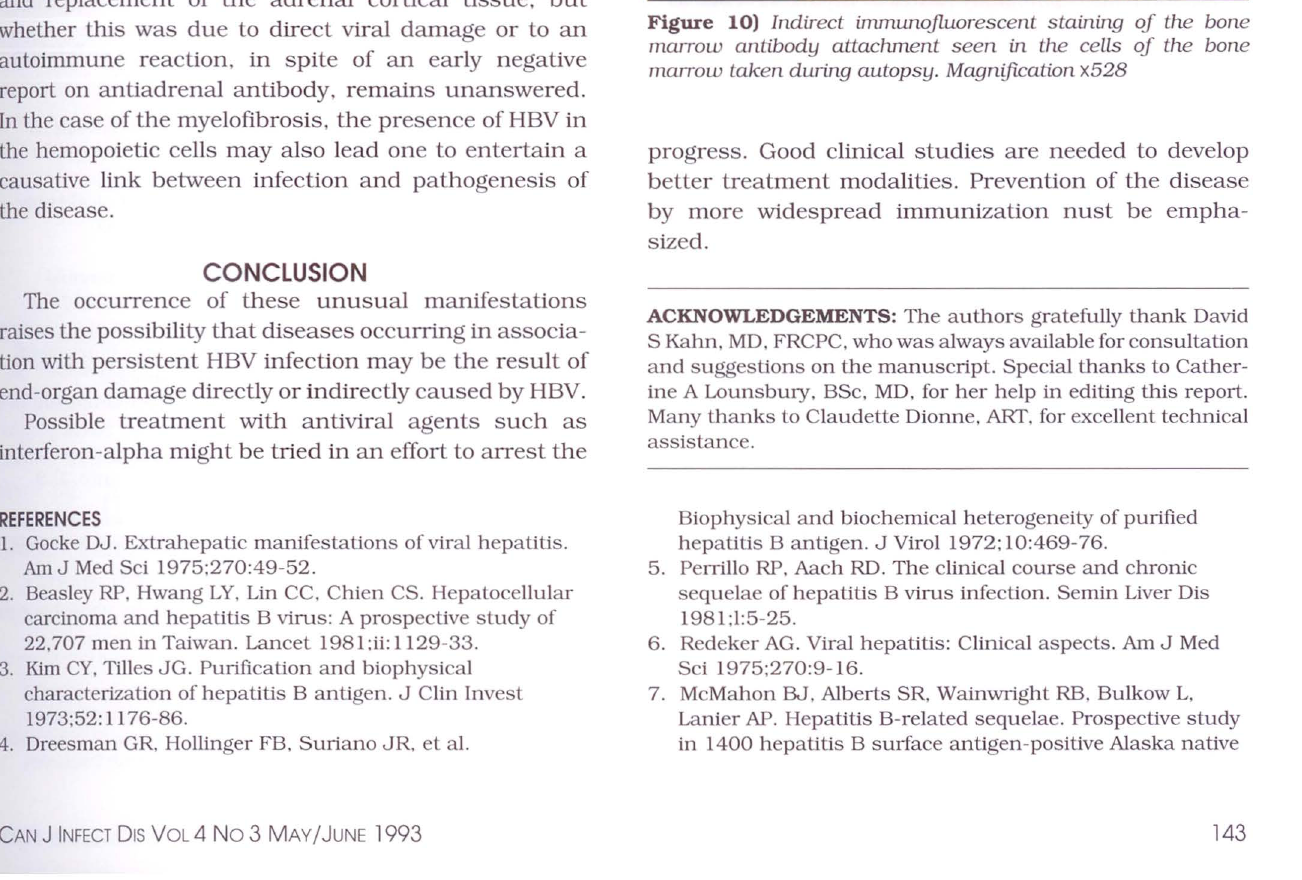
Figure 8) Absorption of the hepatitis B human immunoglobulin by hepatitis B vaccine (Recombivax) no antibody attachment seen in the cells of the bone marrow. Magnification x264 tissue, resulting in a secondary effect on the hemopoie tic cells (44,45).